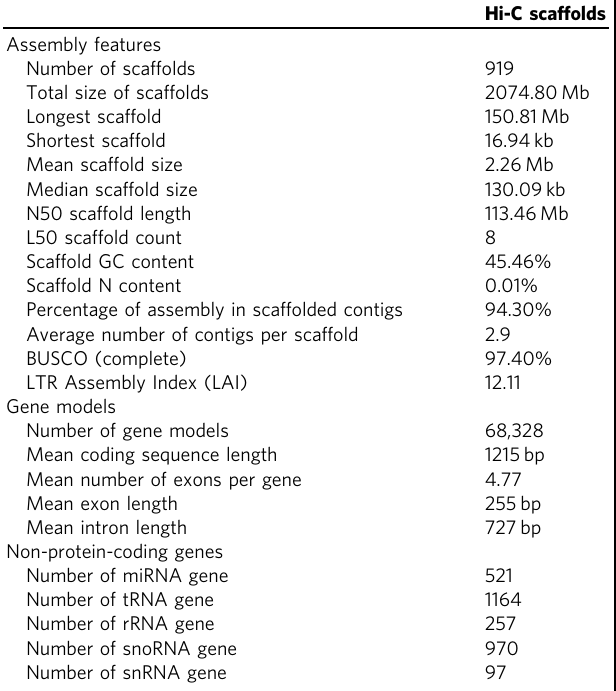
Table 1 Statistics of genome